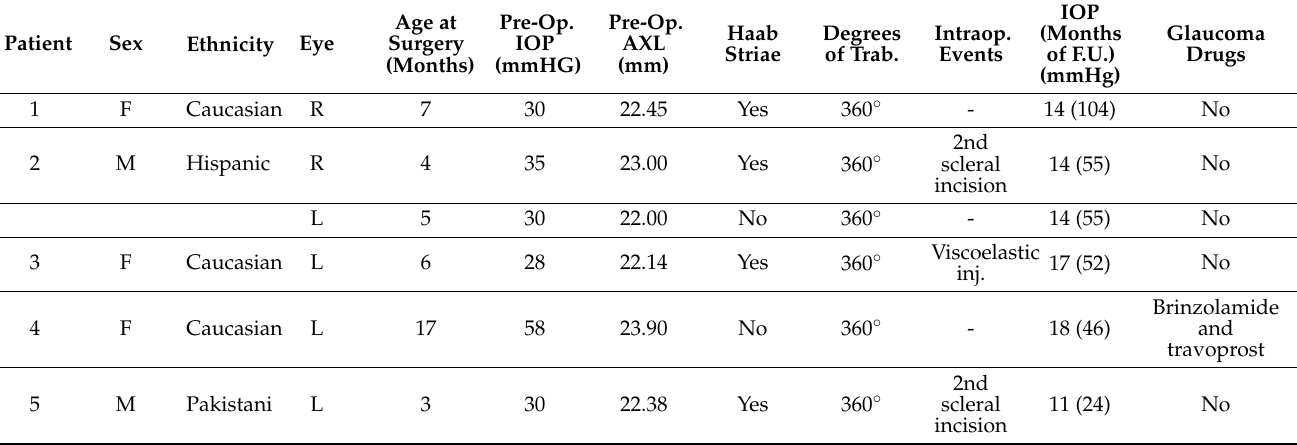
Table 1. Characteristics of the study